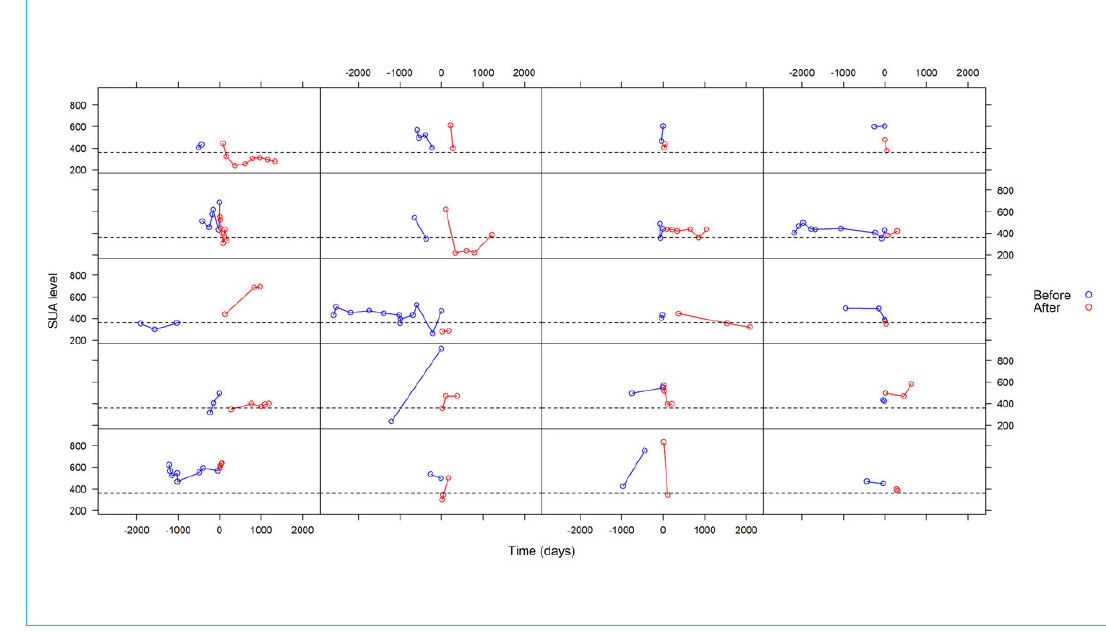
Figure 2: The variation of SUA measurements among a randomly chosen sample of treated patients (men and women). Blue circles define SUA level measurement before treatment was started. Red circles define SUA level measurements after treatment was started. The zero- point on the timeline is defined as the day when treatment was started. SUA = serum uric